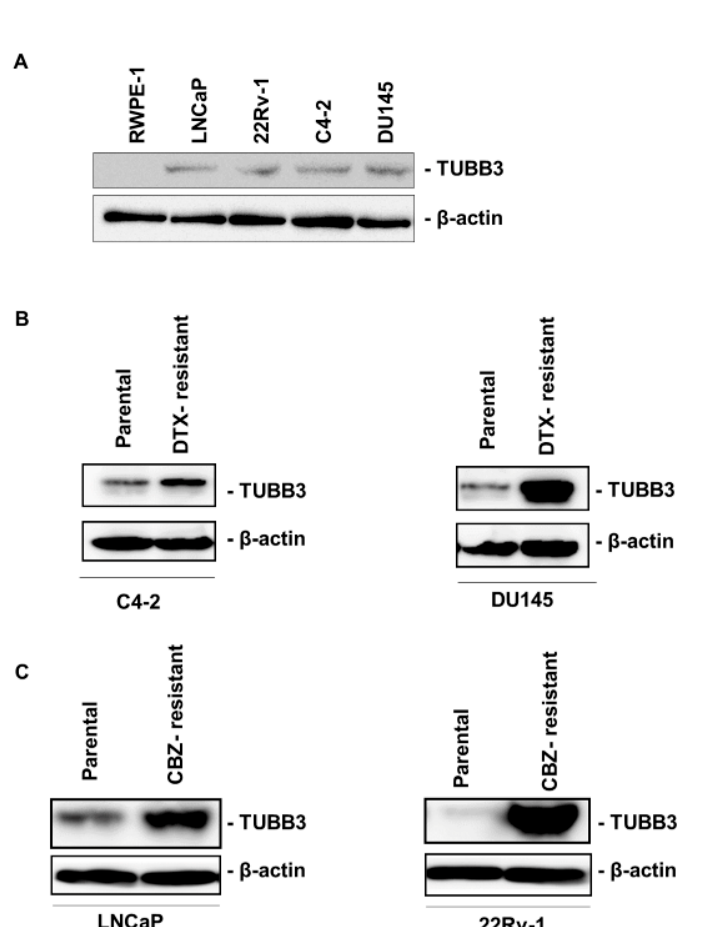
Figure 2. TUBB3 is overexpressed in docetaxel (DTX)-resistant cell lines and cabazitaxel (CBZ)-resistant cell lines. ( A ) Western blotting of TUBB3 in RWPE-1, LNCaP, 22Rv-1, C4-2 and DU145 cells. β -actin was used as a loading control. ( B ) Western blotting of TUBB3 in parental and DTX-resistant cell lines in C4-2 and DU145 cells. β -actin was used as a loading control. ( C ) Western blotting of TUBB3 in parental and CBZ-resistant cell lines in LNCaP and 22Rv-1 cells. β -actin was used as a loading control.